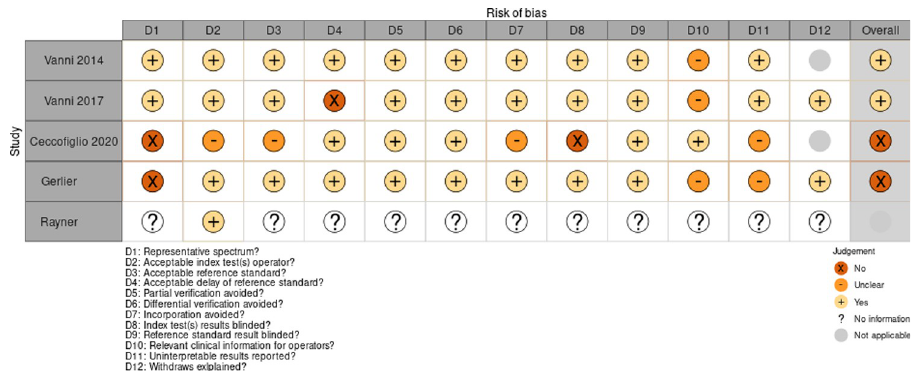
Fig 2. Traffic light plot of the risk of bias within studies. The diagram summarises the risk of bias within the individual studies, based on QUADAS-2 tool derived adjusted recommended quality items for each of the twelve domains. QUADAS = Quality Assessment tool for Diagnostic Accuracy